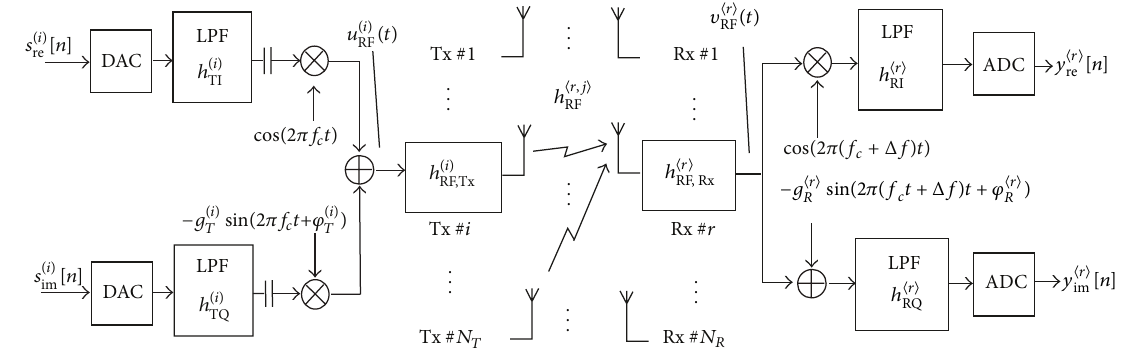
Figure 1: System model with CFO and frequency-selective I/Q